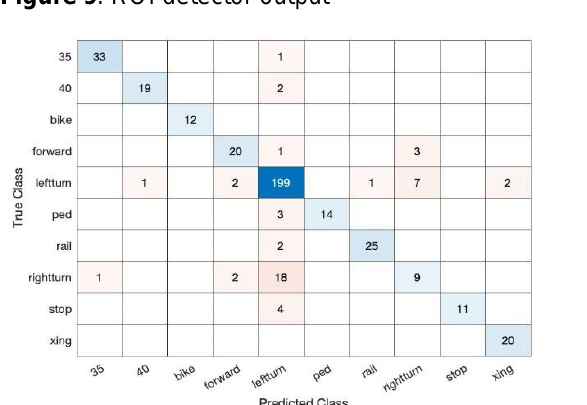
Figure 9 . ROI detector output